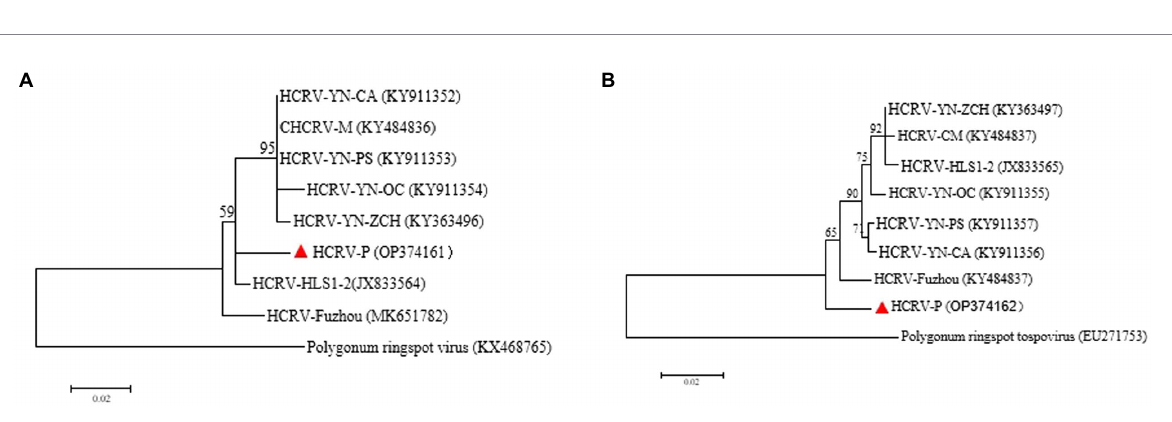
FIGURE. 7 Phylogenetic tree of Hippeastrum chlorotic ringspot virus P. yunnanensis isolate (HCRV-P) and other isolates: (A) Maximum-likelihood trees were constructed based on the partial aa sequences of GPC, (B) ML trees were constructed based on the partial aa sequences of NP. Bootstrap analysis was applied using 1,000 bootstrap replicates. The scale bar representing a genetic distance of 0.2. Polygonum ringspot tospovirus, a species in the genus Orthotospovirus , was used as an outgroup. Solid triangle indicated the HCRV-P isolate characterized in this